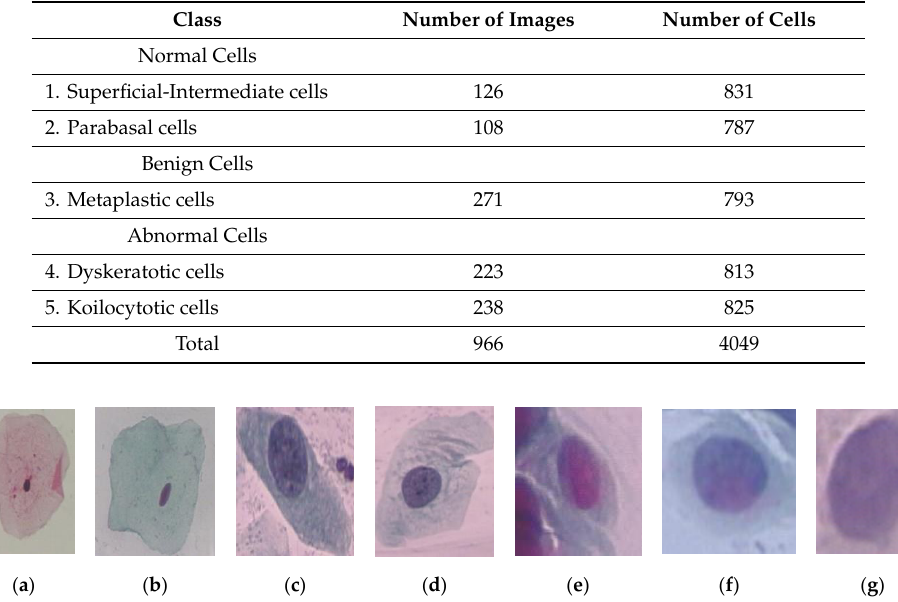
Figure 3. Single cells images of seven classes: ( a ) Superficial squamous epithelia, ( b ) Intermediate squamous epithelia, ( c ) Columnar epithelial, ( d ) Mild squamous non-keratinizing dysplasia, ( e ) Moderate squamous non-keratinizing dysplasia, ( f ) Severe squamous non-keratinizing dysplasia, ( g ) Squamous cell carcinoma in